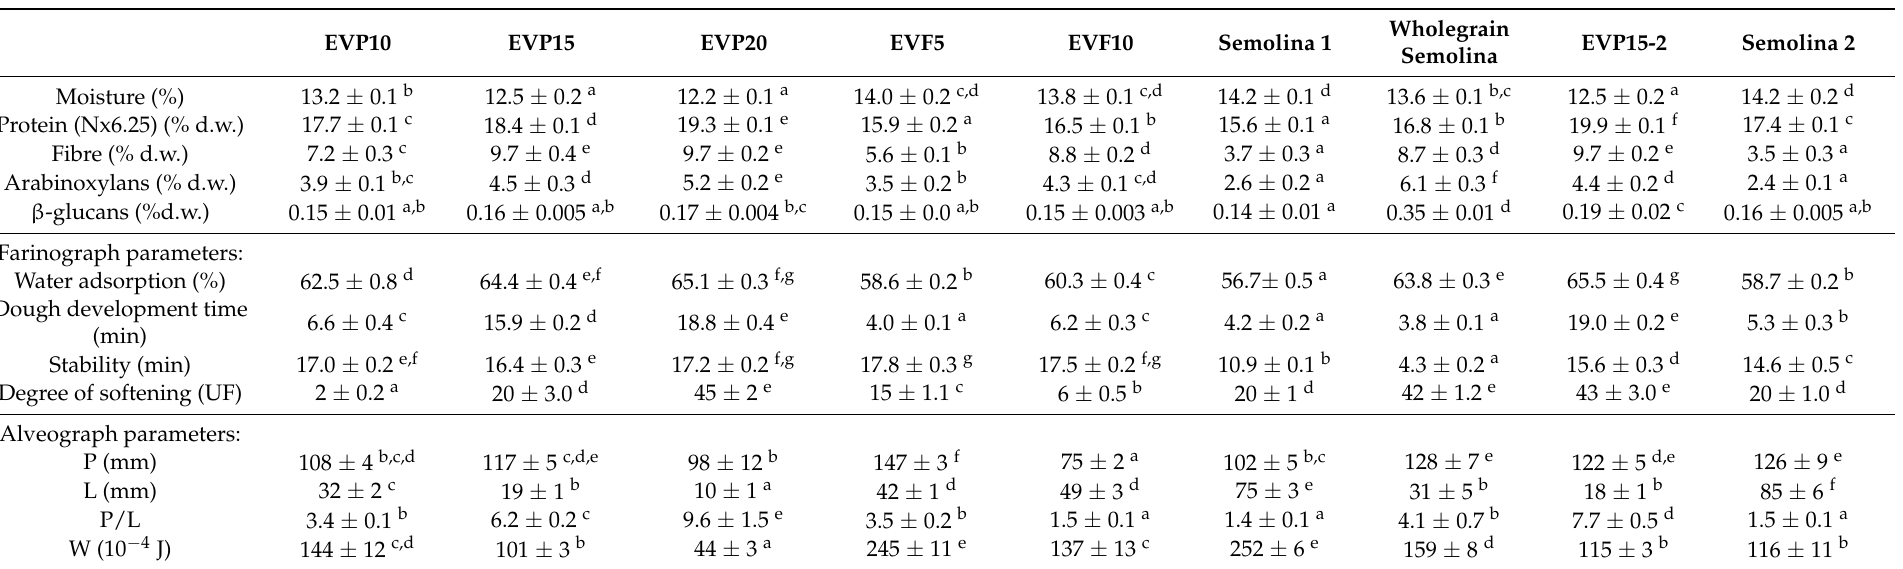
Table 4. Moisture, protein, fibre, and arabinoxylans content of semolina and EVP and EVF blends and results from Farinograph and Alveograph tests. Different letters in rows indicate statistically significant differences ( p <